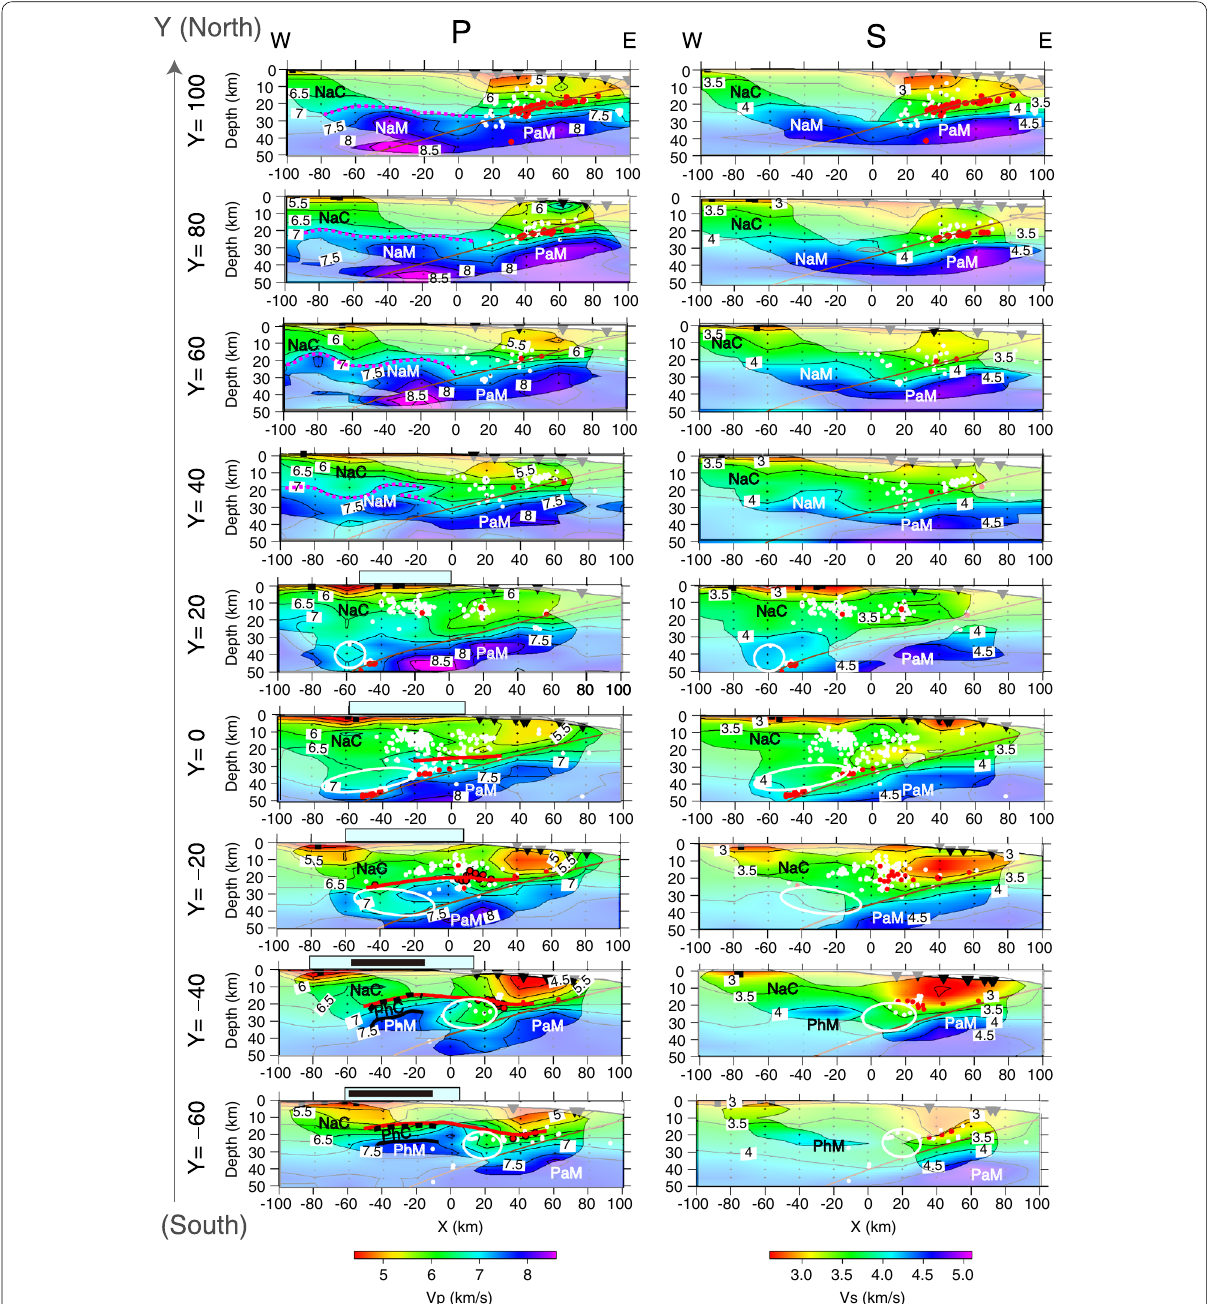
Fig. 7 Results of the tomographic inversion along the X -axis. The black triangles and squares in each panel indicate the stations within 10 km of each section. The white and red dots indicate all faulting earthquakes and low-angle thrust-faulting earthquakes within 10 km of each section, respectively. The brown line indicates the depths of the upper boundaries of the PAC (Nakajima et al. 2009). PaM, NaC, NaM, PhC, and PhM indicate the crustal (C) and mantle (M) parts of the three plates: PAC (Pa), NA (Na), and PHS (Ph). The areas surrounded by white lines indicate low-velocity regions in the PHS. The magenta dashed lines on the sections north of Y 40 km indicate the smoothed iso-velocity contour of Vp 7.0 km/s in = = the NA. The black bold and dashed lines on the sections south of Y 40 km represent the iso-velocity contours of Vp 7.5 km/s in the PHS and = − = the top of the crust of the PHS, respectively (see the text for details). The red circles with bold black outlines indicate the low-angle thrust-faulting earthquakes used to estimate the upper boundary of the PHS. The bold red lines indicate the newly proposed upper boundary of the PHS. The black and light blue lateral bars at the top of each cross-section indicate slow slip areas with slips larger than 5 cm in the 2007, 2011, and 2014 SSEs (Hirose et al. 2014; Sato et al. 2017) and larger 1 cm in the 2014 SSEs (Sato et al.